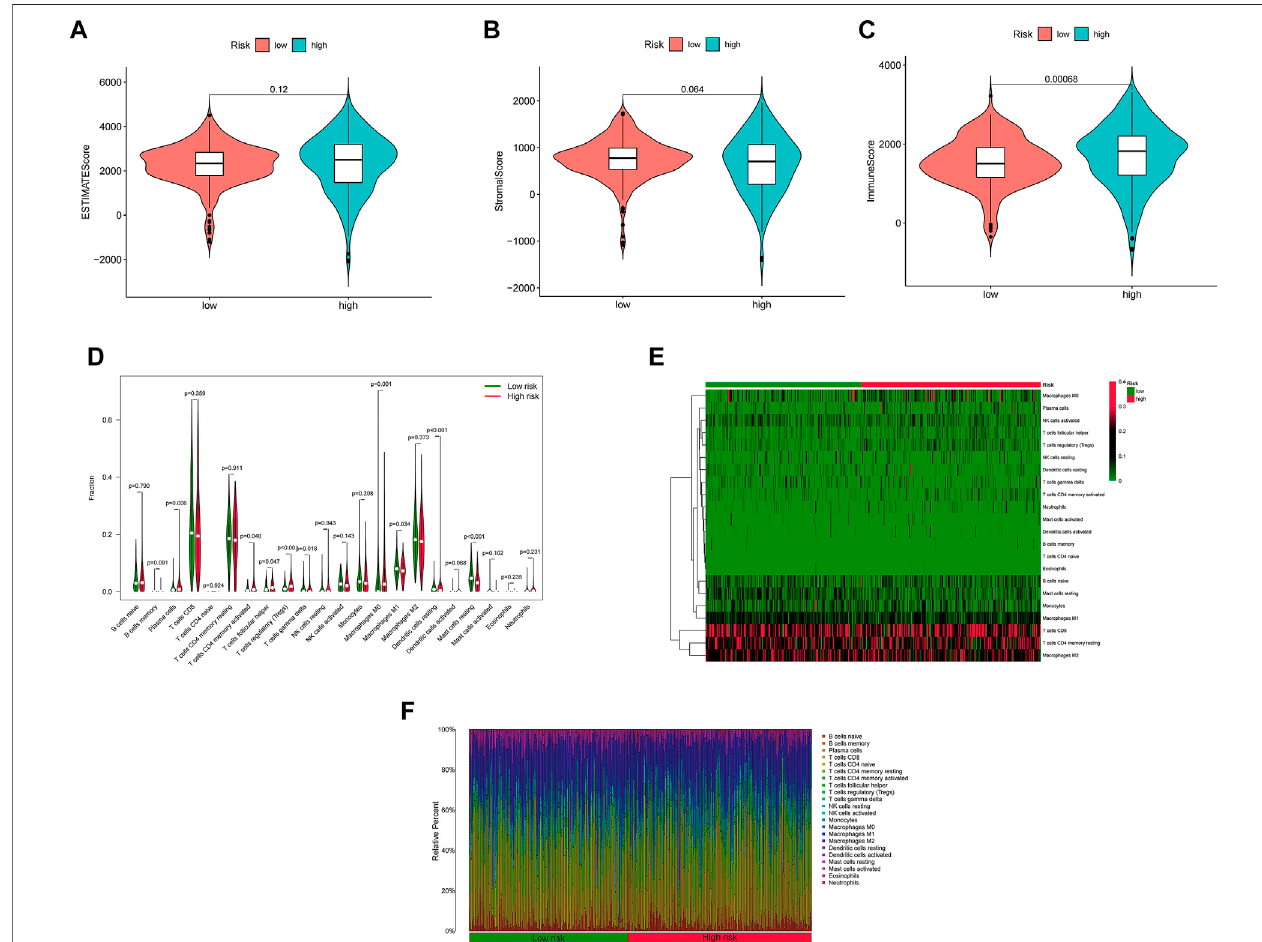
FIGURE 7 | The investigation of tumor immune factors and immunotherapy (A,B) The comparison of ESTIMATE scores and stromal scores between two groups. (C) Thecomparisonofimmunescoresbetweentwogroups. (D) Theviolinplotfordifferenttypesofimmunecellsbetweentwogroups. (E) Theheatmapofimmunecells in two groups. (F) The bar plot for different types of immune cells in each sample (G – J) The survival curves strati fi ed by dendritic cells, mast cells, T cells follicular helper and T cells regulatory (Tregs) (K) The heatmap of different immunefunctions (L) The comparison ofimmunefunctions between two groups (M) The comparison of TIE between two groups (N) The immunotherapy prediction of risk groups. Note: ns = non sense. “ * ” represents p < 0.05; “ * ” p < 0.01; “ *** ” p <